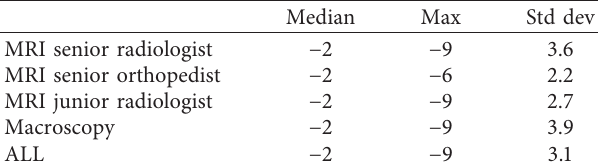
Table 6: Reliability with PSI (in mm) with patient 5.